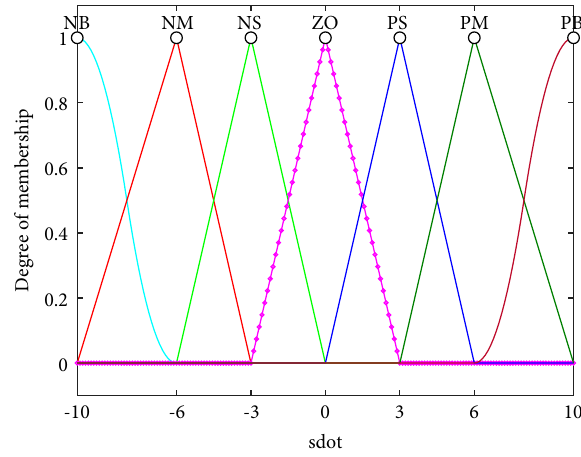
Figure 3: The input membership function of s . Figure 4: The input membership function of